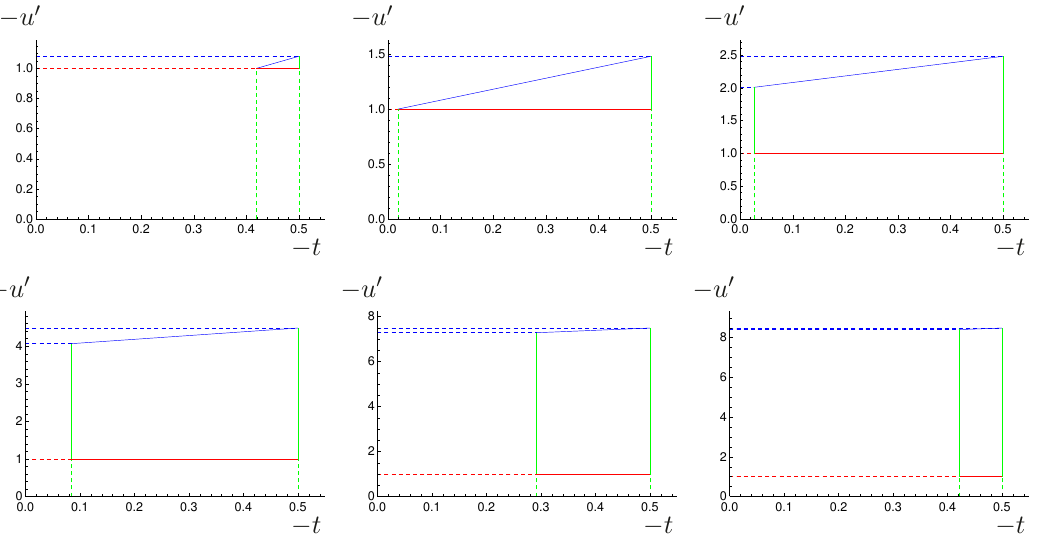
= 1 . 6 GeV 2 (up left), M 2 γπ = 5 GeV 2 (down left), M 2 γπ